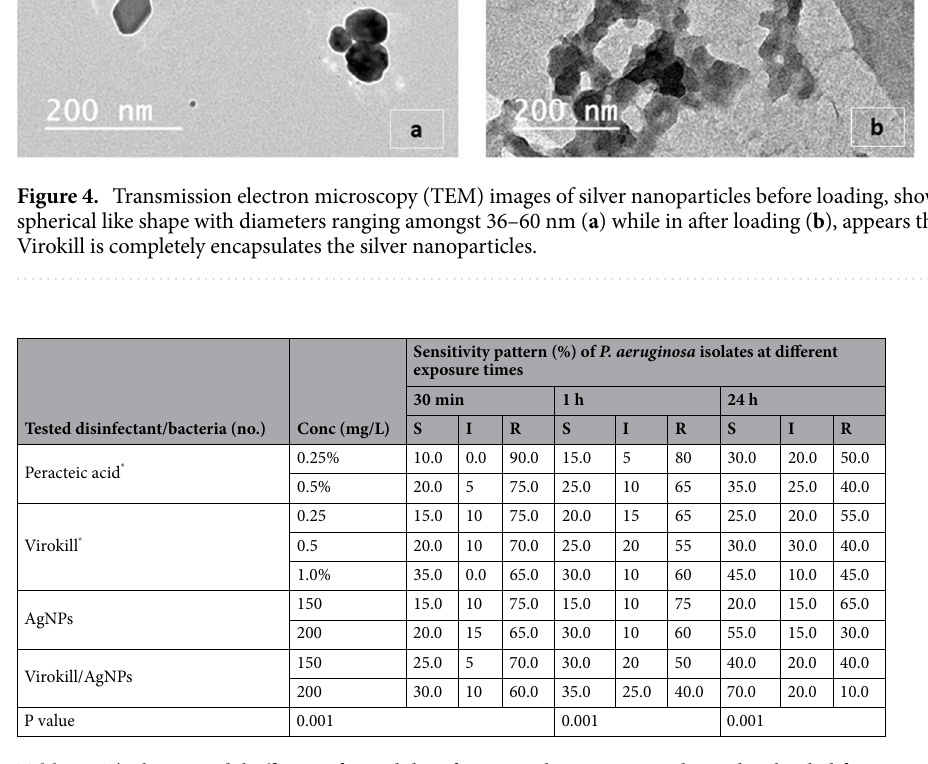
Table 4. The bactericidal efficacy of tested disinfectants, silver nanoparticles and its loaded forms against P. aeruginosa traits. S Sensitive, I Intermediate, R Resistant.